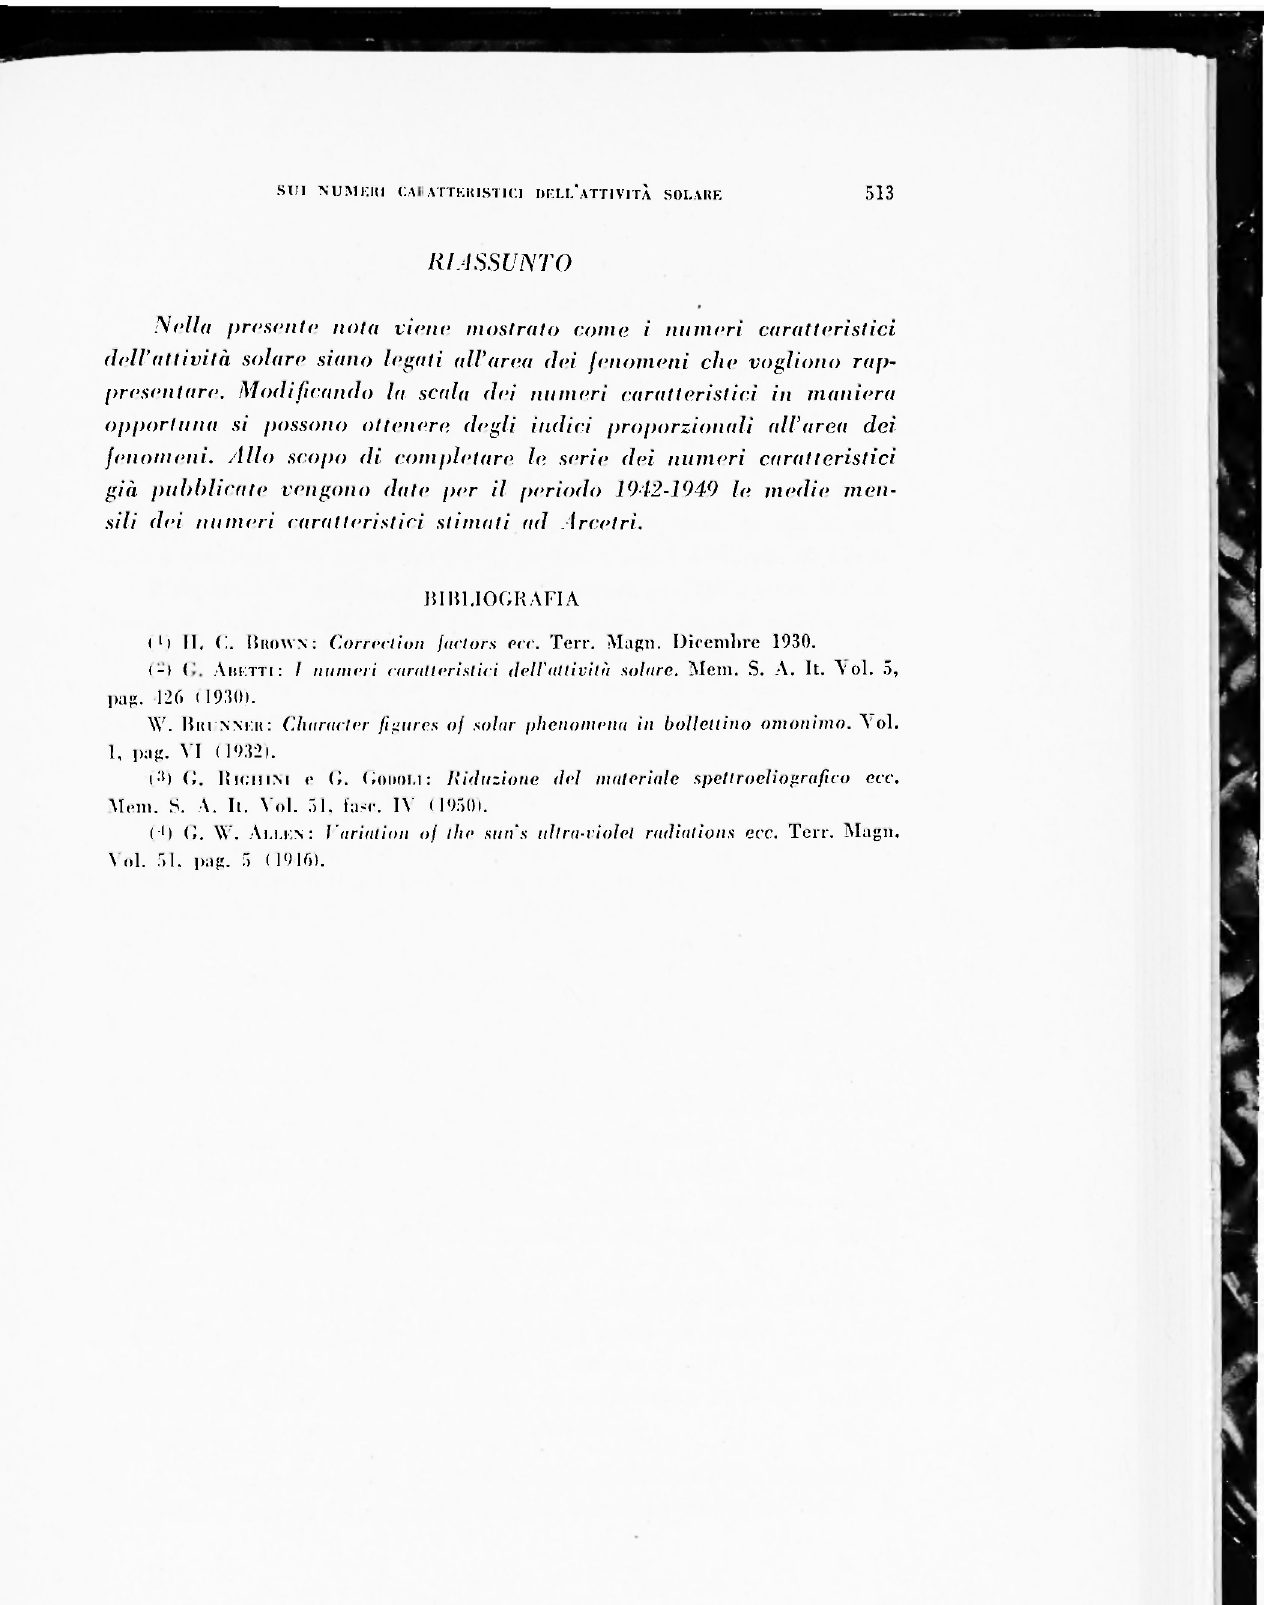
figure* oj solar phenomena in bollettino omonimo.